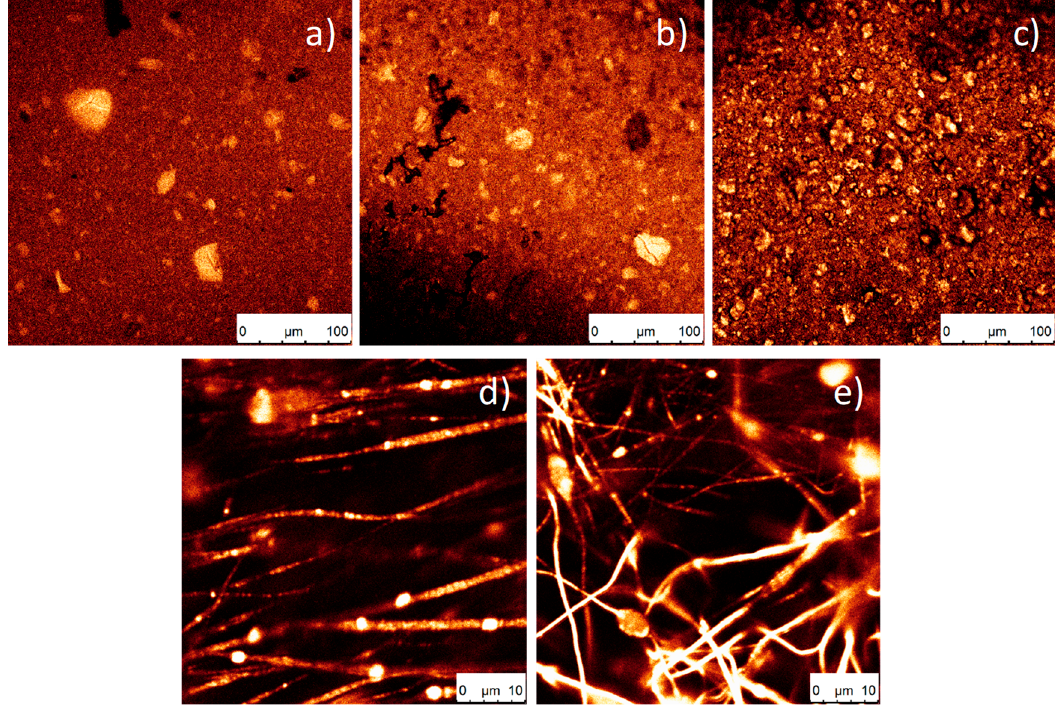
Figure 4. Representative confocal images of SiNPs/PVDF nanocomposites with different morphologies: ( a ) F210-17NP, ( b ) F90-17NP, ( c ) Ftrt-17P, ( d ) O-17P and ( e ) R-17P.